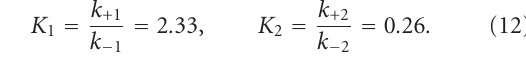
lines, representing the simulated reactive rectifying profiles,